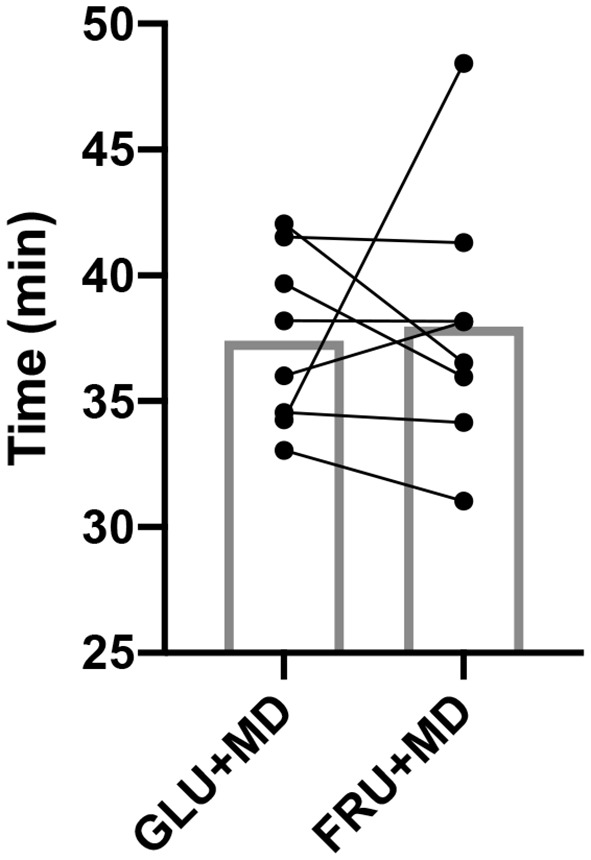
Time to complete the TT. Bars represent mean, while dots and connecting lines represent individual participants.